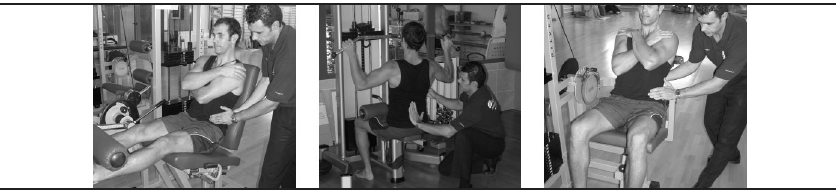
Figure 7. Improve strength is based on specific